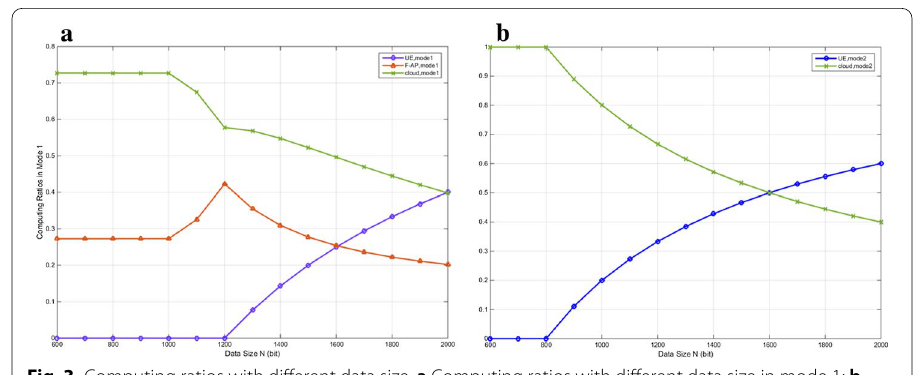
Fig. 3 Computing ratios with different data size. a Computing ratios with different data size in mode 1; b Computing ratios with different data size in mode 2